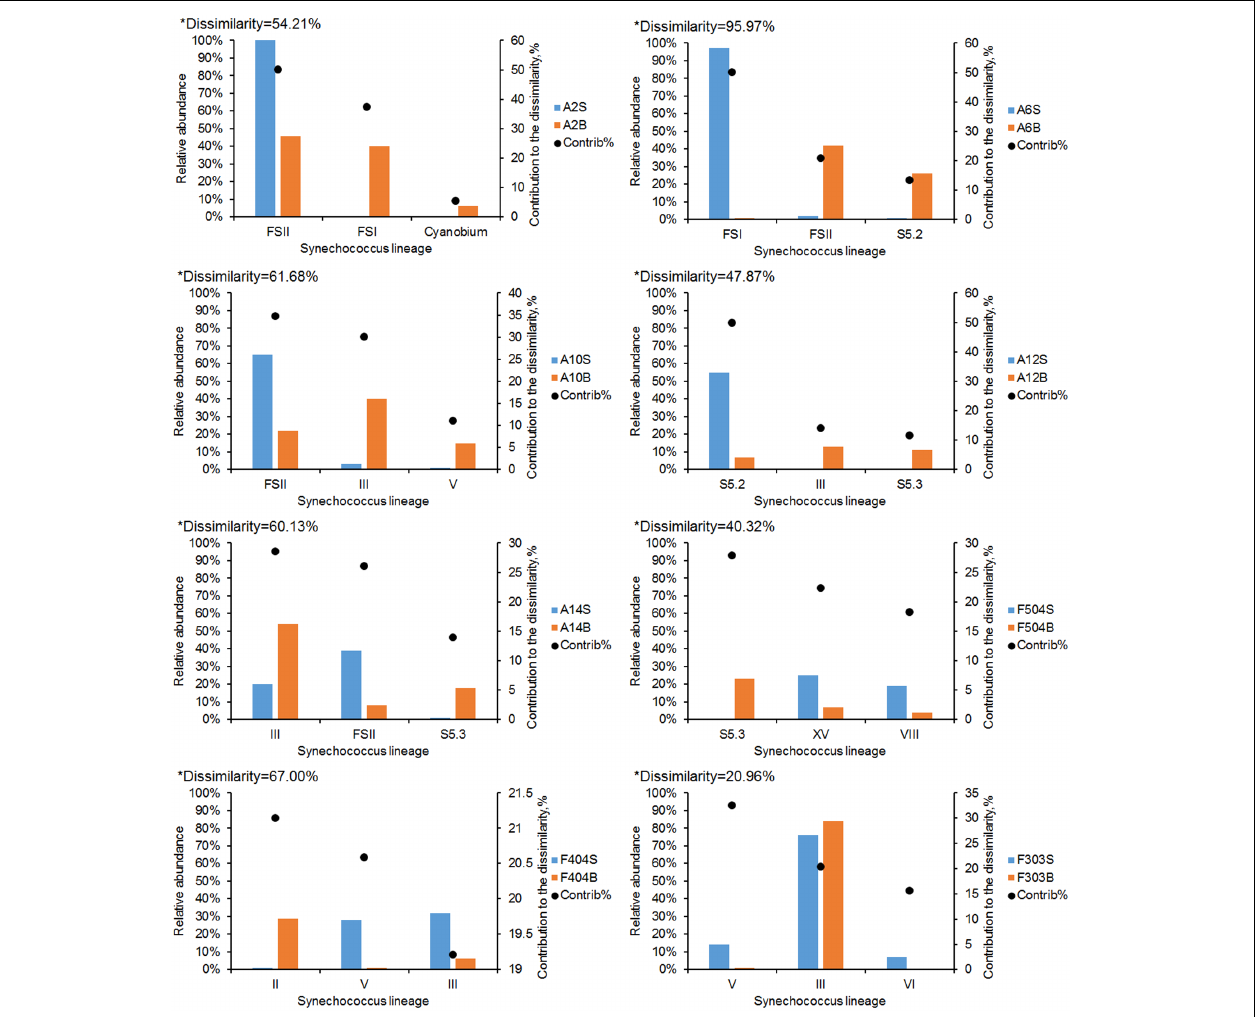
FIGURE 4 | SIMPER analysis of the dissimilarity between Synechococcus communities in the surface and bottom waters in each station. Bar charts show the relative abundance of the three Synechococcus lineages that contributed most to the dissimilarity of communities. ∗ The dissimilarity between the surface and bottom Synechococcus